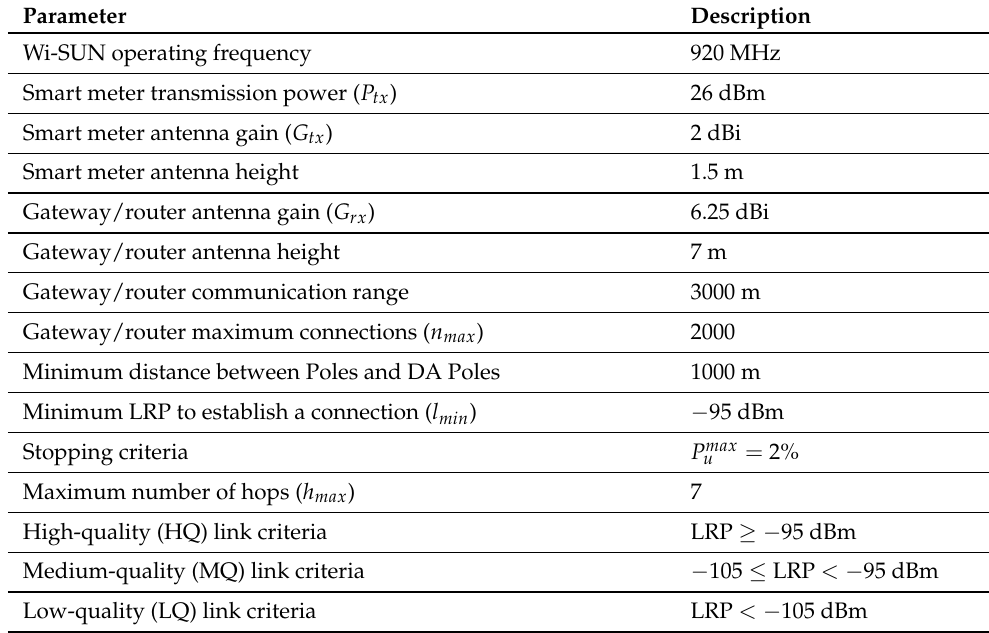
Table 3. Equipment and method